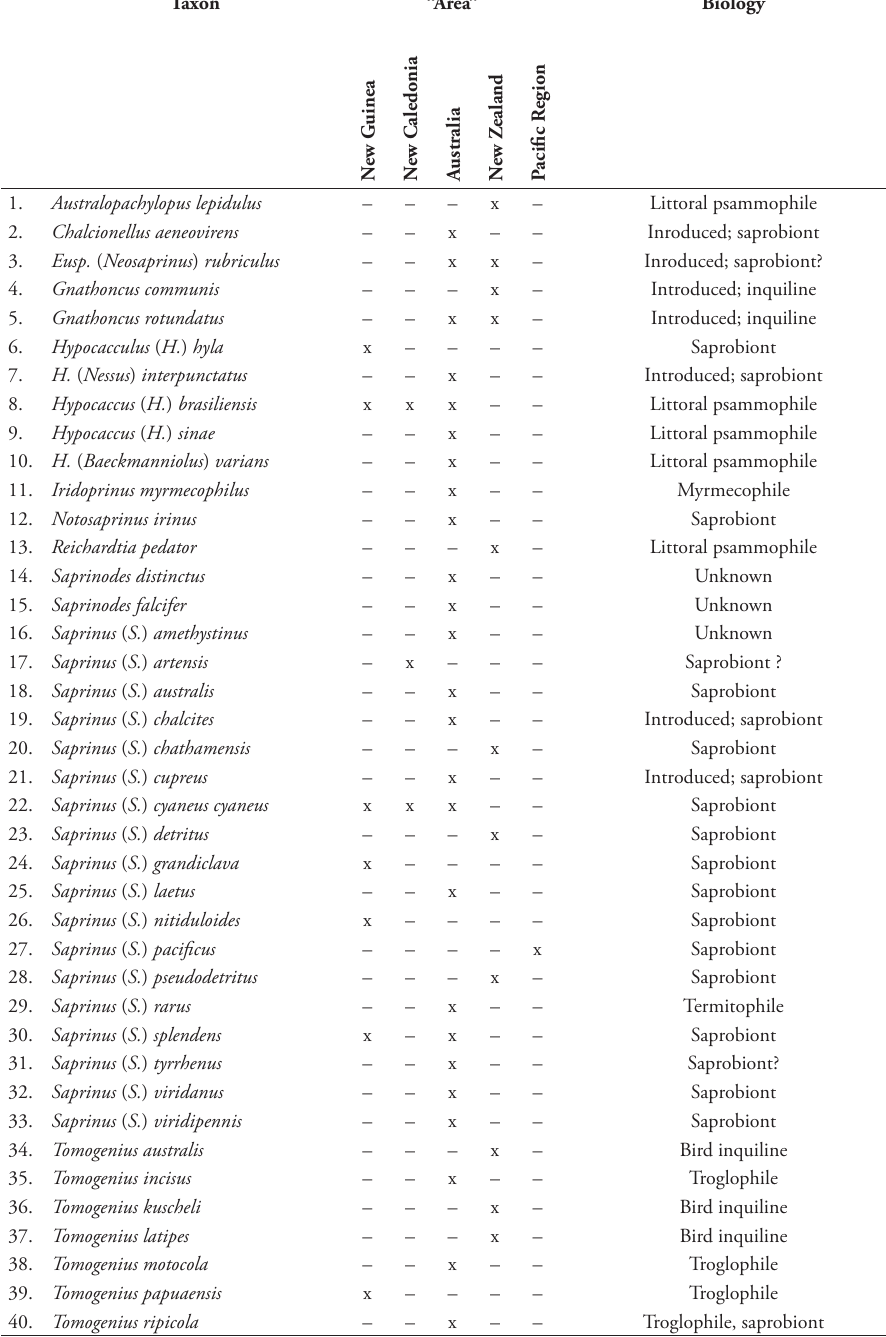
Table 1. Distribution and ecologies of the Australopacific Saprininae.